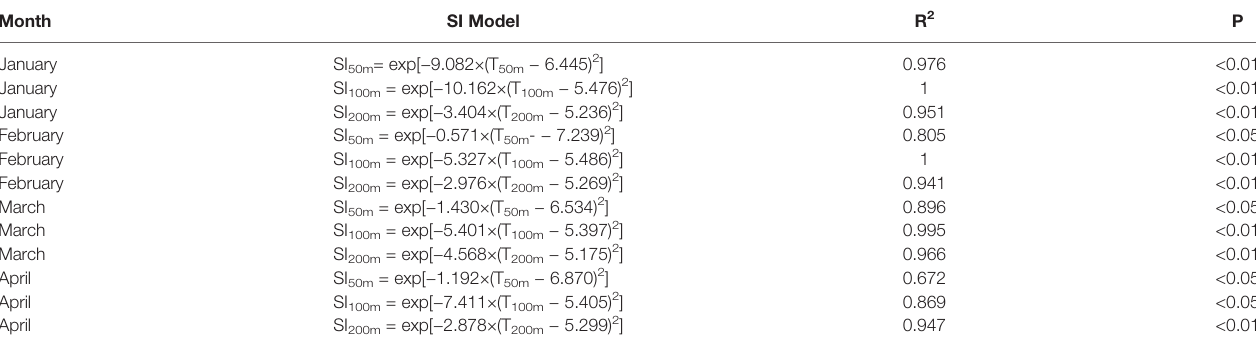
TABLE 2 | Fitting formula of SI models.